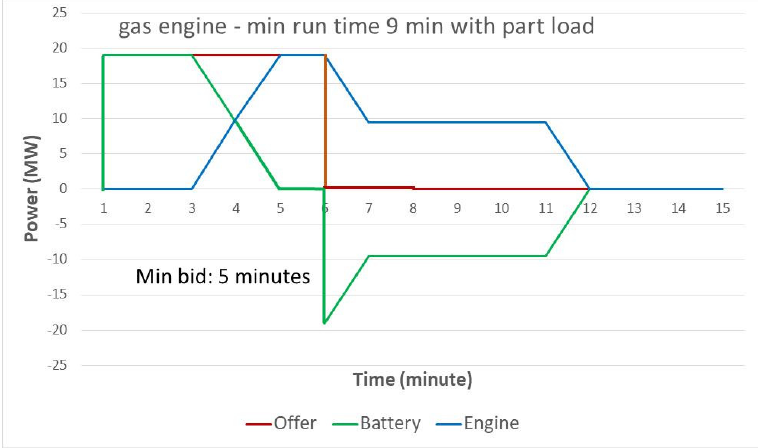
Figure 4. Operation strategy 1- hybrid energy exchange under full load.